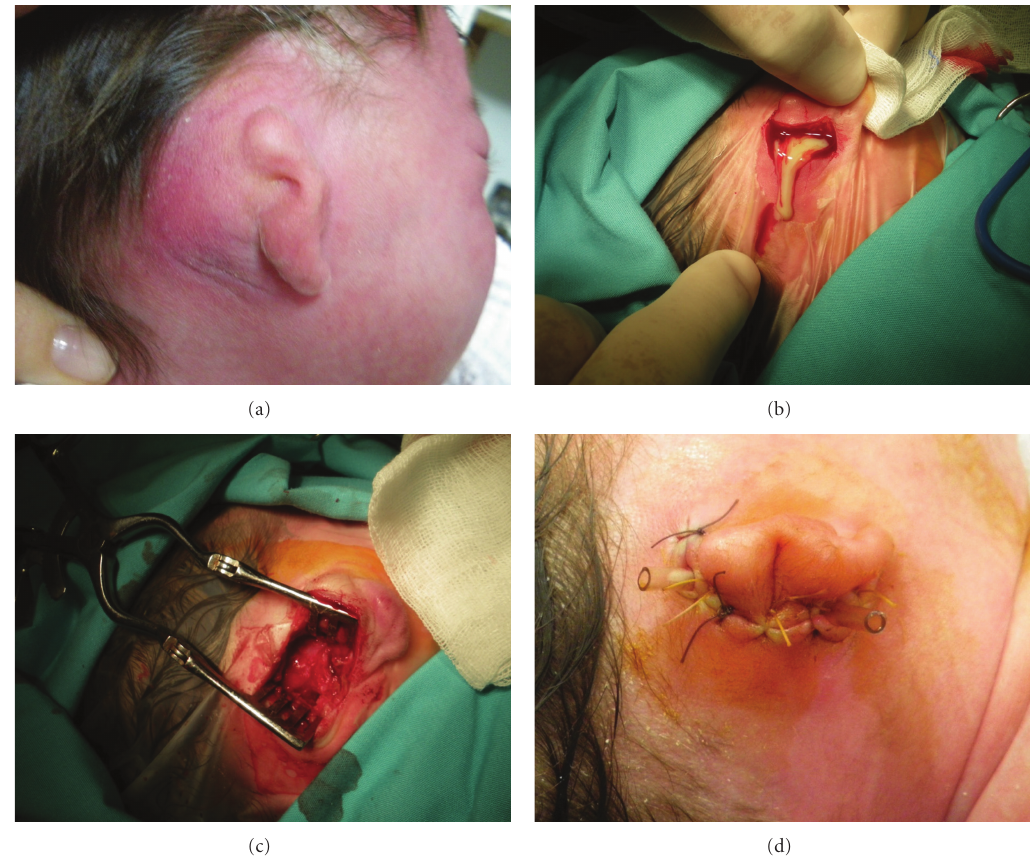
Figure 1: Pre- (a), intra- (b) and (c), and immediate postoperative (d) view of the atretic ear with the mastoiditis.